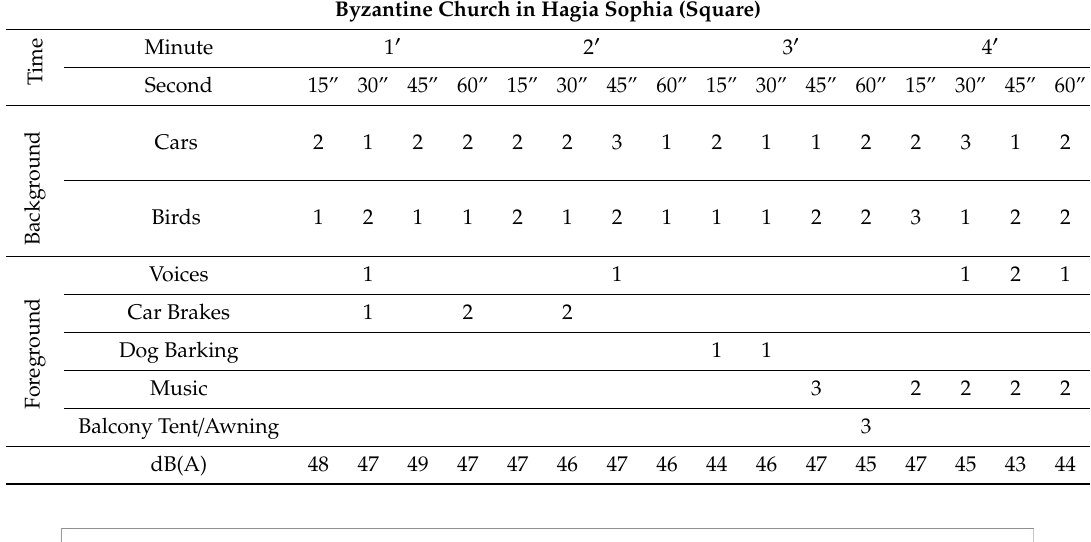
Table 3. The soundscape characteristics of Byzantine Church in Hagia Sophia Square as highlighted by the researchers.